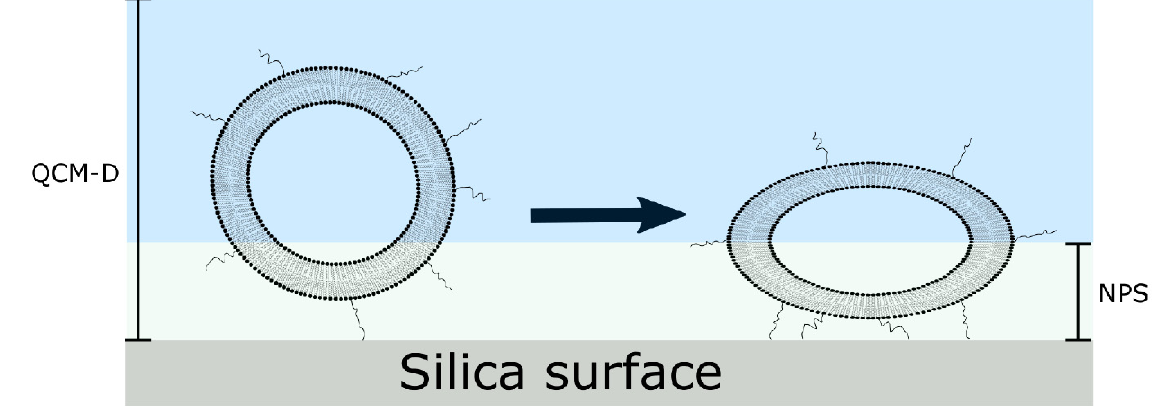
Figure 14. Effect of temperature on the mass (as determined by QCM-D) of immobilized liposome layers formed by DSPC (solid line) and by DSPC:DSPE-PEG2000 (96:4 moL%—dotted line).